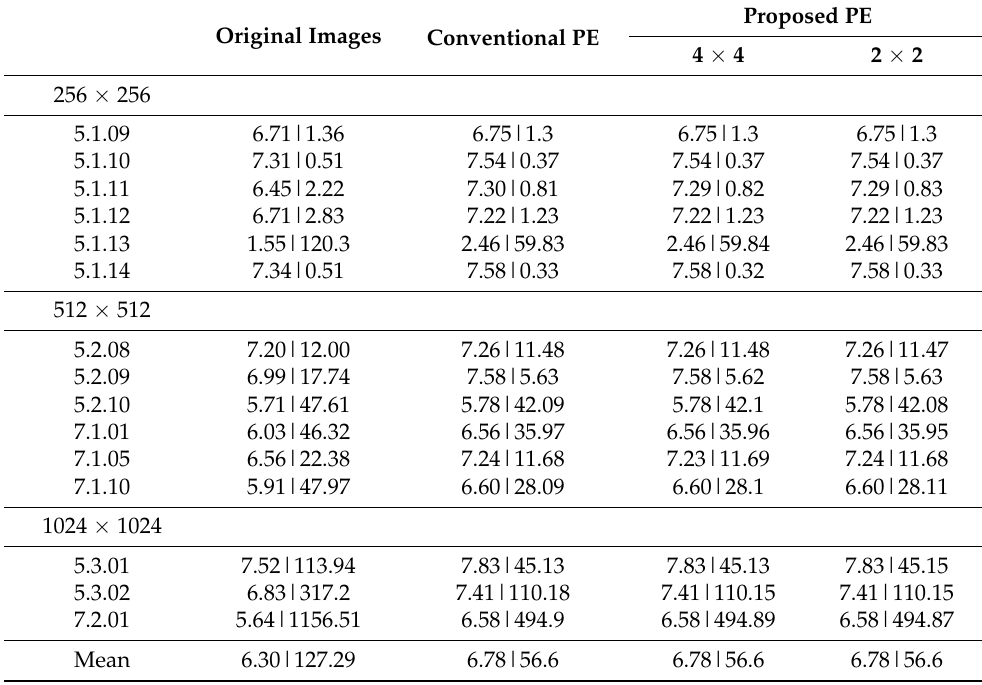
Table 2. Histogram variance and information entropy analysis of perceptual encryption algorithms. The values are given as information entropy|(histogram variance × 10 5